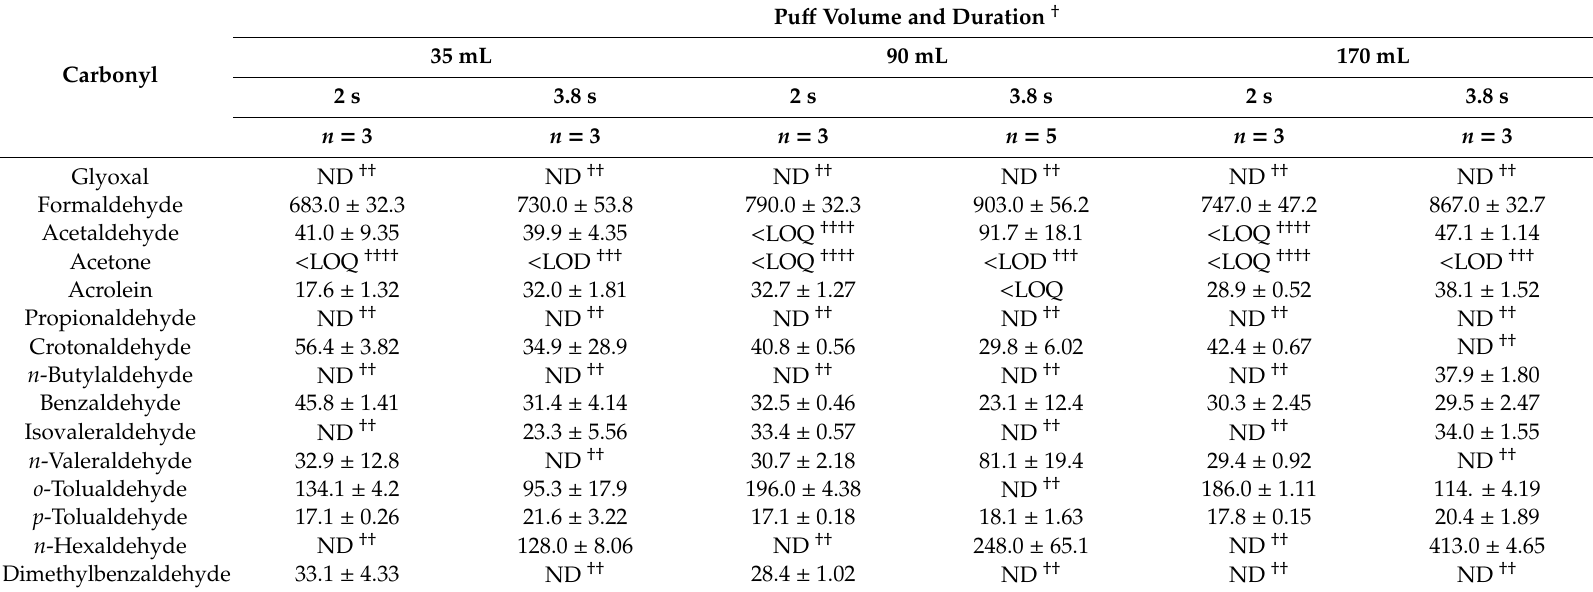
Table 2. Impact of vaping topography on carbonyl levels in e-vapor (mean ± standard deviation, ng / pu ff